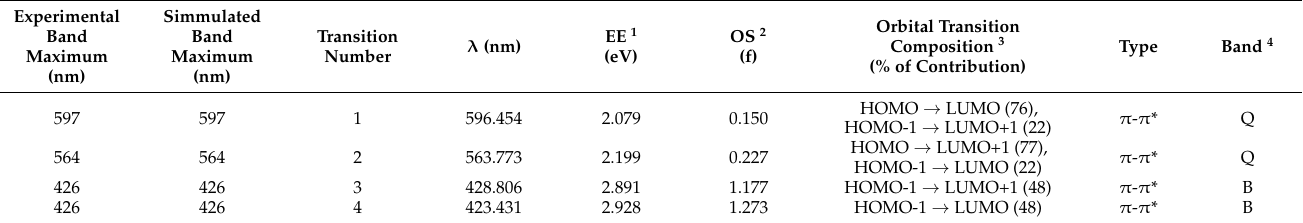
Table 2. The essential vertical excitations of 4 at the PCM/TD-DFT/PBE1PBE/6-